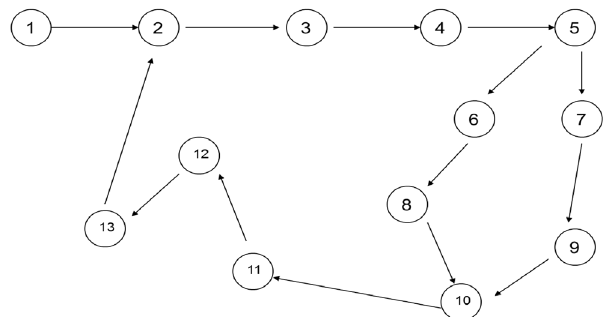
Figure 3. State chart diagram.